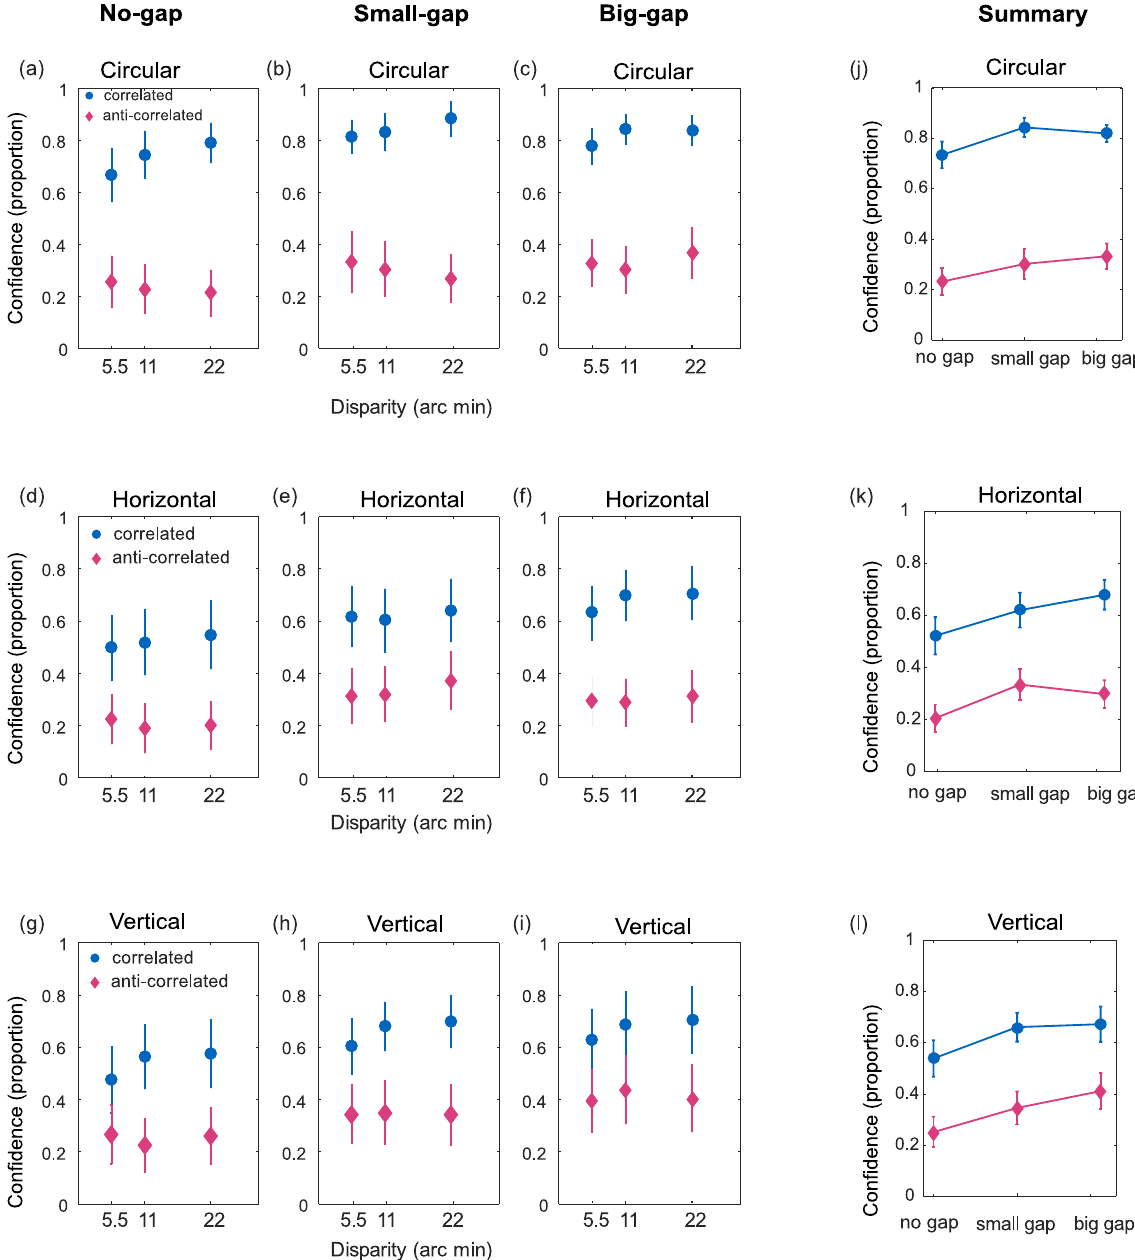
Figure 9. ( a – i ) Mean confidence (proportion) for CRDS (blue) and ACRDS (pink) are plotted as a function of disparity and gap size and shape. Error bars show ± 1 standard error of the mean. ( j – l ) Summary of confidence in depth detection with each shape on separate plots. Plotted as a function of gap size for CRDS (blue) and ACRDS (pink), an averaged over